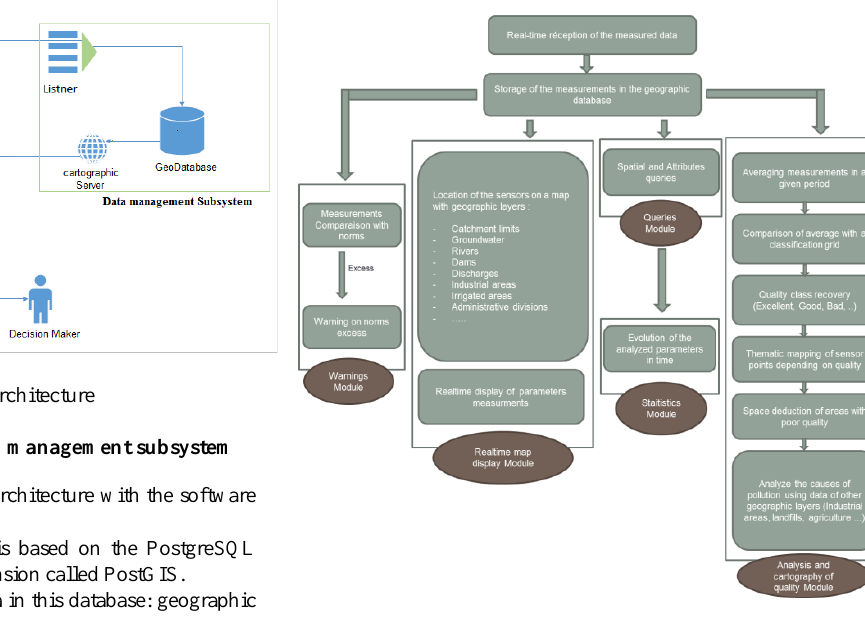
Figure 4. Functional architecture of the GIS